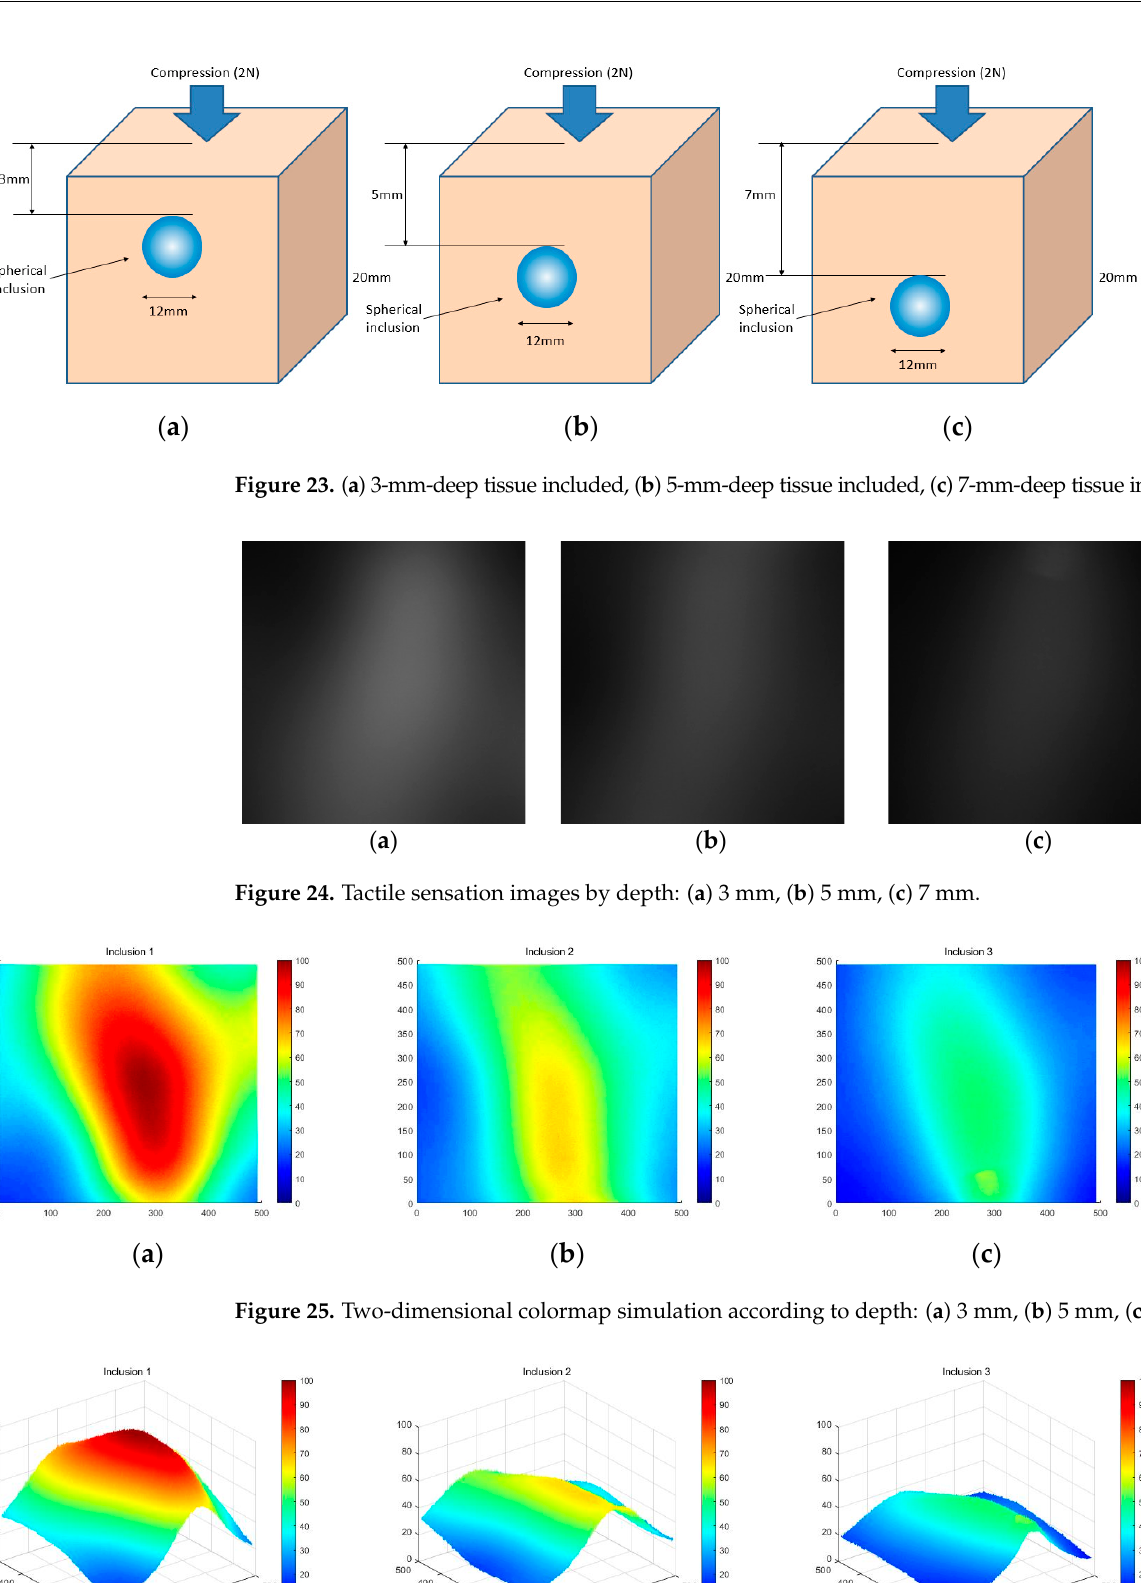
Figure 27. Z-score graph by depth. 4.1.3. Inclusion-Size Phantom Figure 28 shows that the Inclusion 1 and Inclusion 2 phantoms had the same nodule elasticity of 110 kPa and depth of 5 mm but were fabricated differently, with sizes of 8 mm and 12 mm, respectively. Considering that the sizes of thyroid nodules are about 5–10 mm, they are sometimes felt by careful palpation—12 mm and 8 mm were designated as the two inclusion sizes. As a result of analyzing the tactile image in Figure 29, Figure 30 shows that the larger the size of the inclusion, the higher the sensitivity of the colormap, and the center is drawn in red. The highest averages of the two phantoms were 78 kPa and 155 kPa; it can be seen that the larger the size, the higher the Z-axis value (Figure 31). Moreover, the result of applying the 3D model indicates that the Z axis was at its highest when the size was 12 mm. Figure 32 shows the graph of the highest z-axis value and shows that the difference can be easily determined.